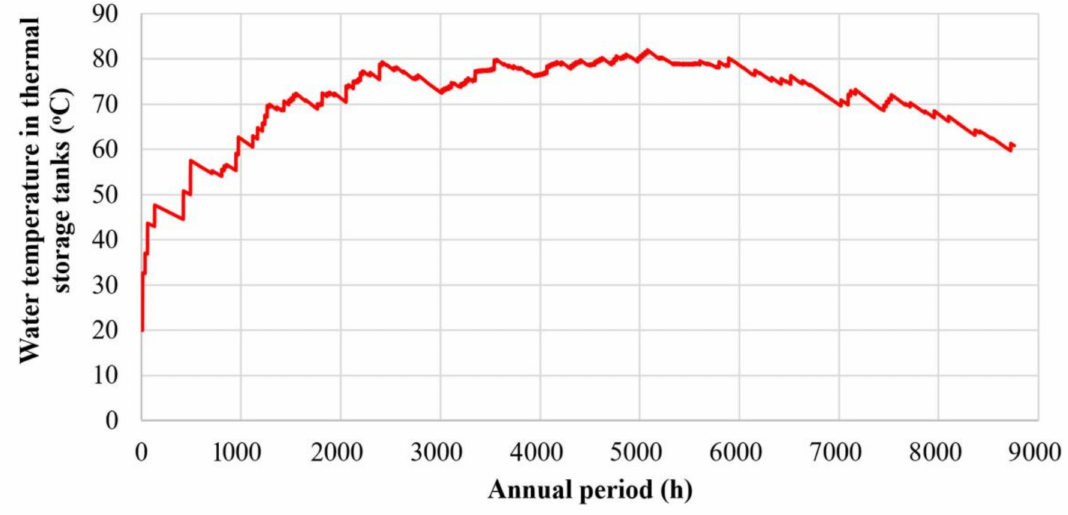
Figure 20. Annual fluctuation of water temperature in the thermal storage